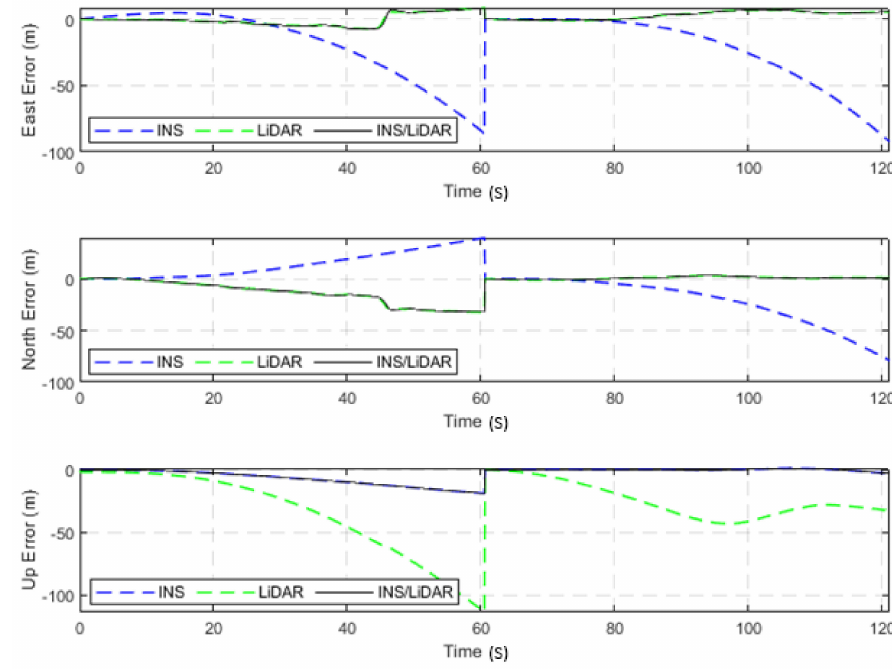
Figure 24. D-42—GNSS-assisted: position errors (ENU).